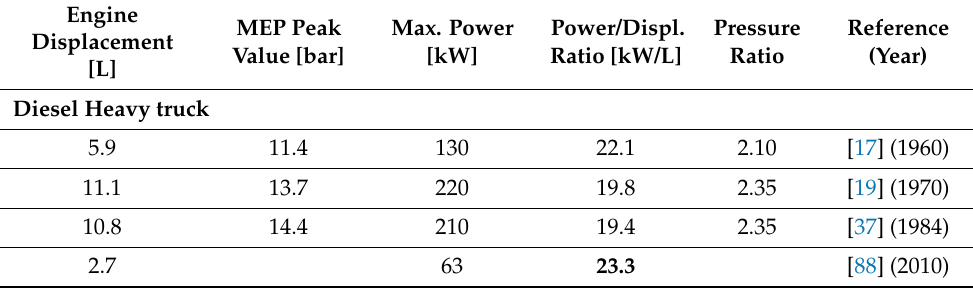
Table 5. Performance values for Comprex applications.